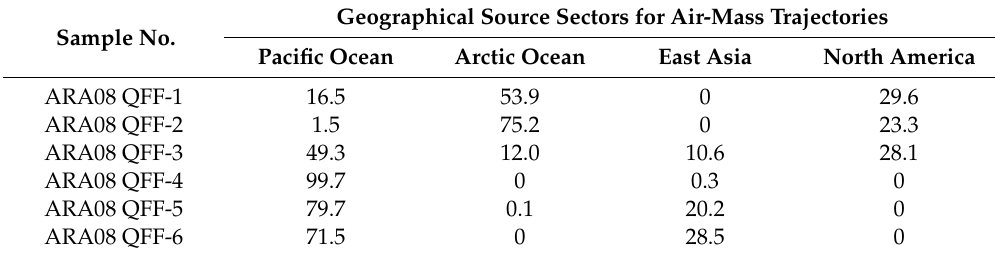
Table 2. Percentages of dominant back trajectories found within each sampling period. Sample